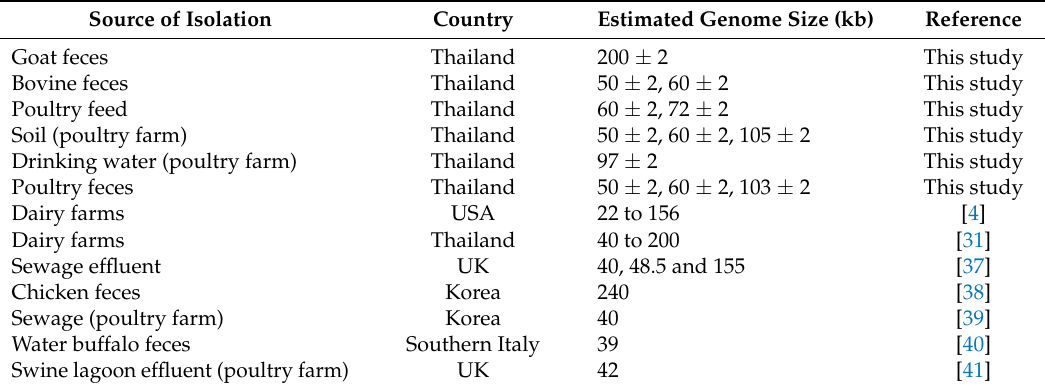
Table 8. Estimated genome size of Salmonella phages isolated from animal farms in this study and Salmonella phage isolated from previous